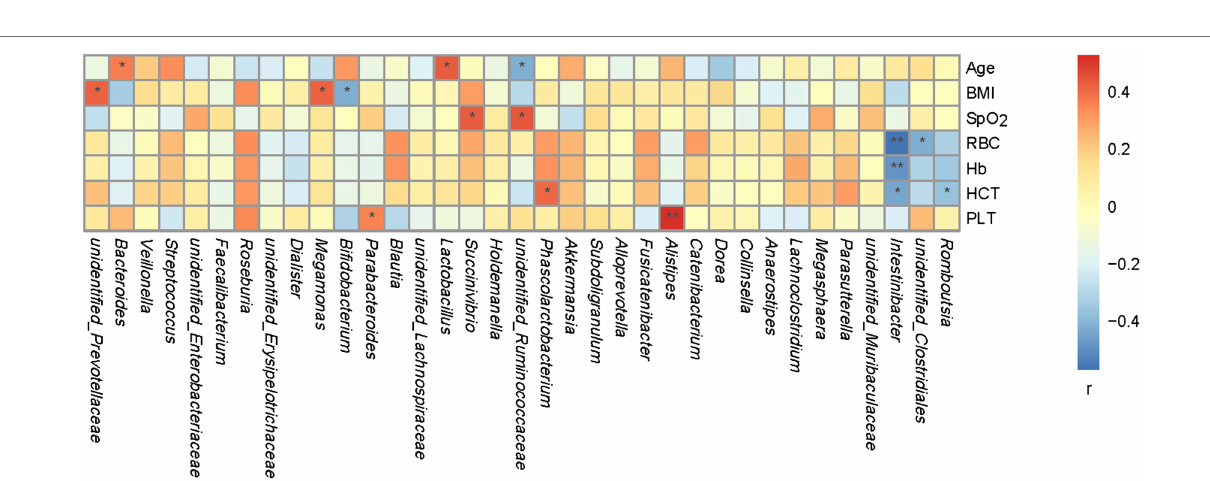
FIGURE 4 | Spearman’s association analysis of bacterial genera and age, BMI, SpO 2 , RBC, Hb, HCT, and PLT. r indicates Spearman’s correlation coefficient. Cells are colored based on the value of r between significantly altered genera and age, body mass index (BMI), oxyhemoglobin saturation measured with a pulse oximeter (SpO 2 ), red blood cells (RBC), hemoglobin (Hb), hematokrit (HCT), and platelet count (PLT). Red represents a significantly positive correlation, blue represents a significant negative correlation, and white represents no significant correlation. * p < 0.05; ** p < 0.01.